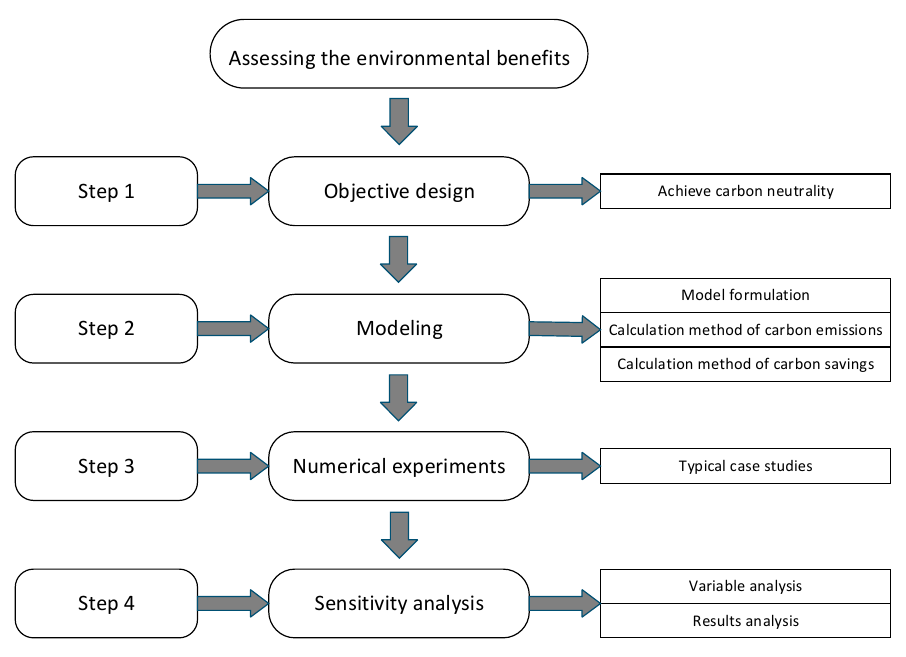
Figure 1. Methodological framework.